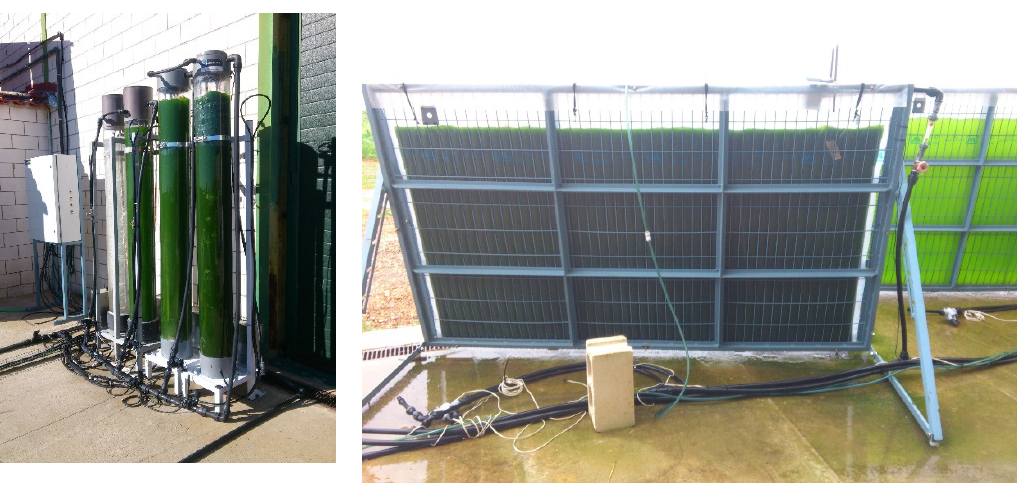
Figure 1. Vertical column and flat-panel photobioreactors.